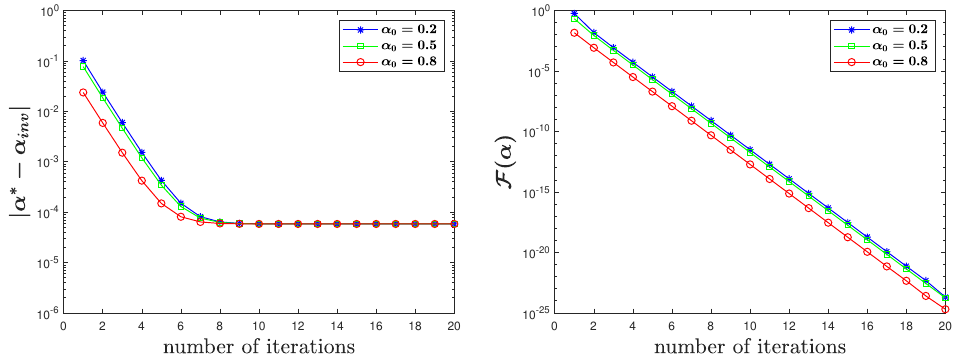
Figure 4. α ∗ = 0.9 for uncontaminated observation data in Test 1.